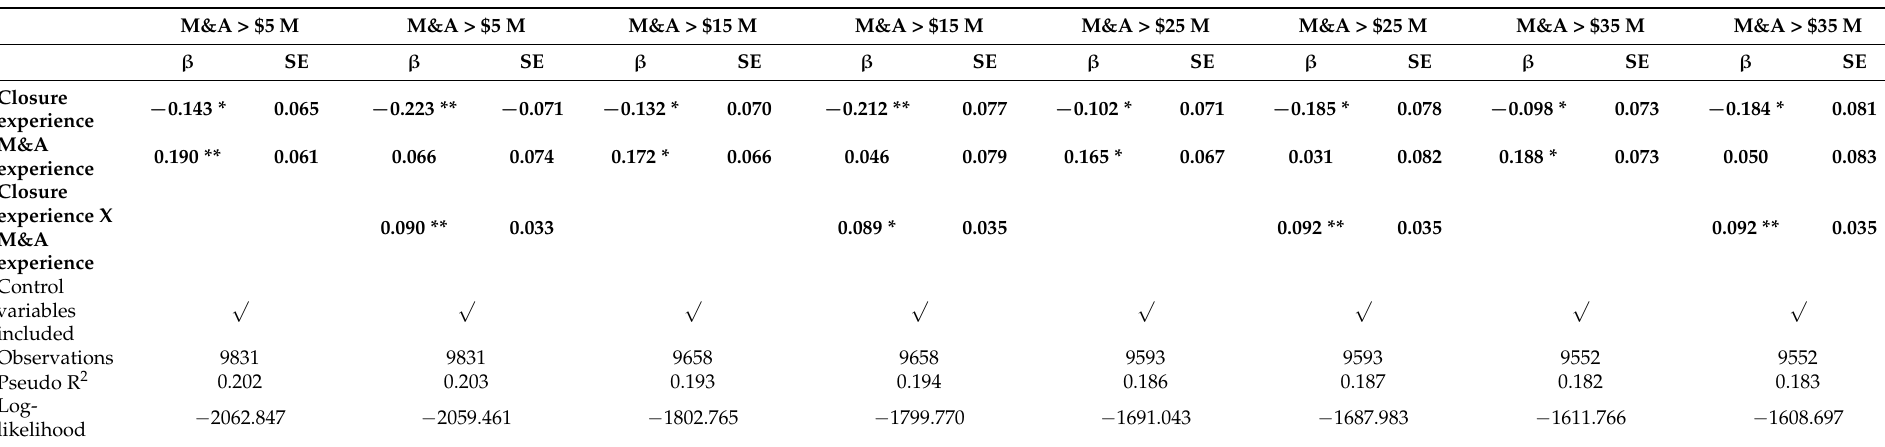
Table 4. Sensitivity analysis: the effect of entrepreneurs’ experience on the probability of M&A with different